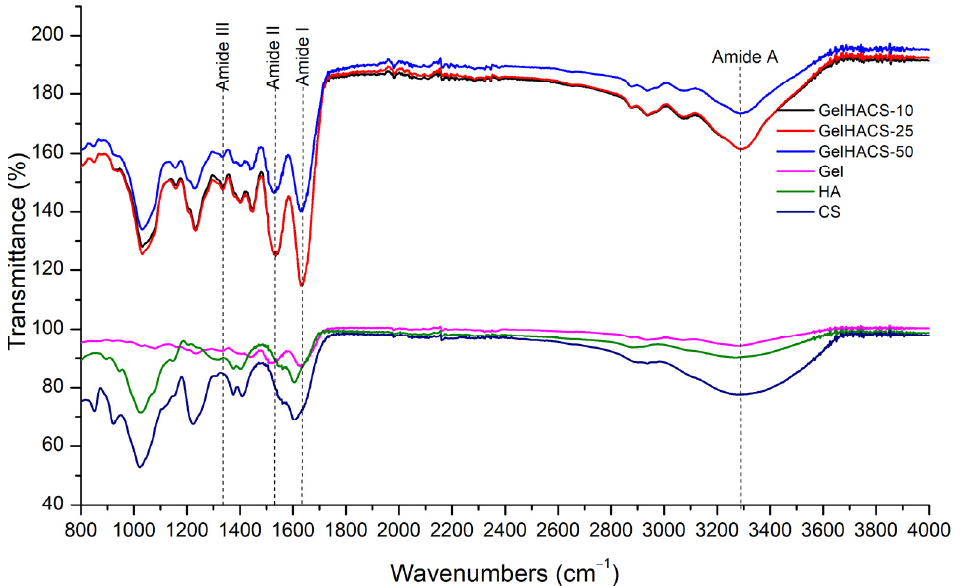
Figure 2. FTIR spectra of GelHACS cryogels.